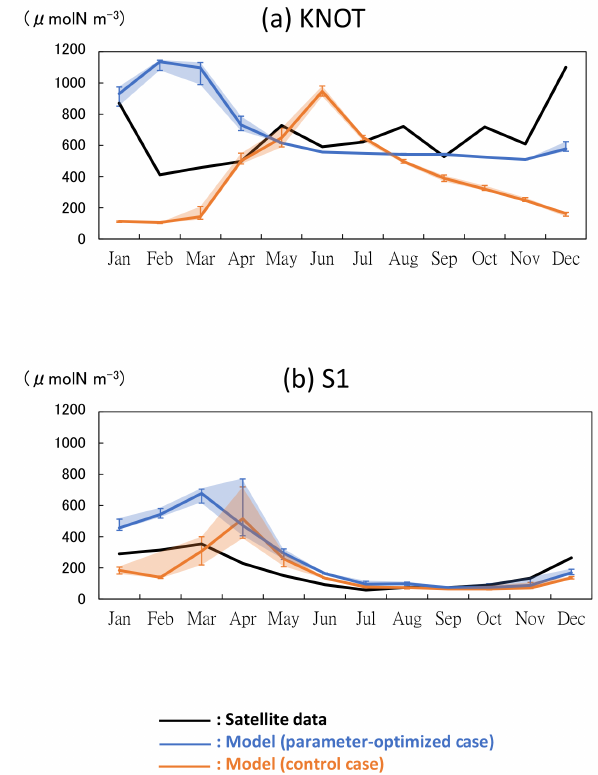
Figure 8. Time series of phytoplankton (PL + PS) concentration in the 3-D NSI-MEM and satellite data at (a) KNOT and (b) S1. Error bars and shade of the simulations show the maximum and minimum values in ± 0.3 ◦ around the grids of KNOT and